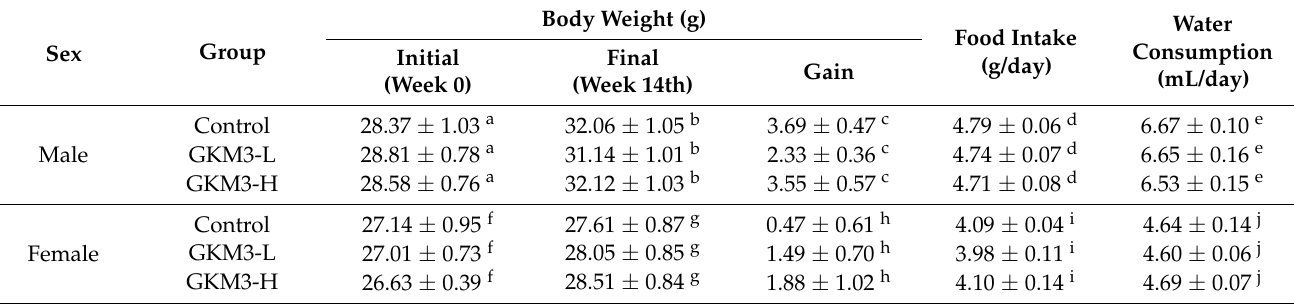
Table 1. Body weight, food intake, and water consumption.